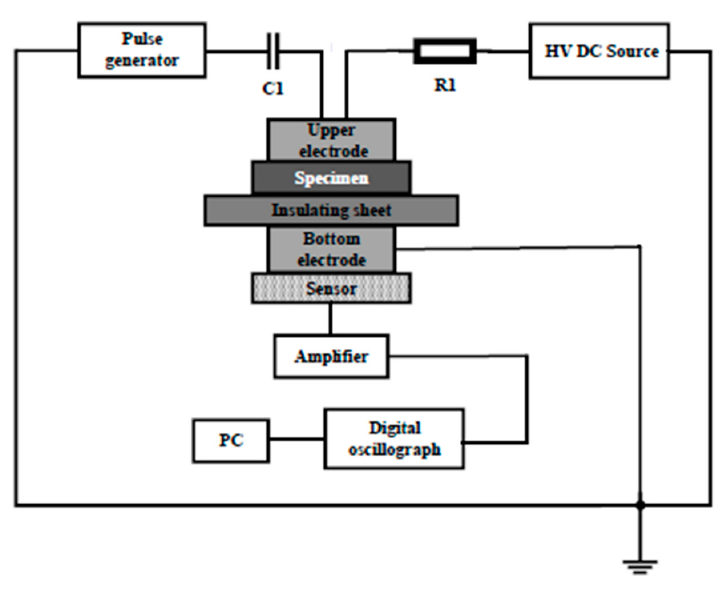
Figure 3. Schematic diagram of the pulse electro-acoustic (PEA) method.